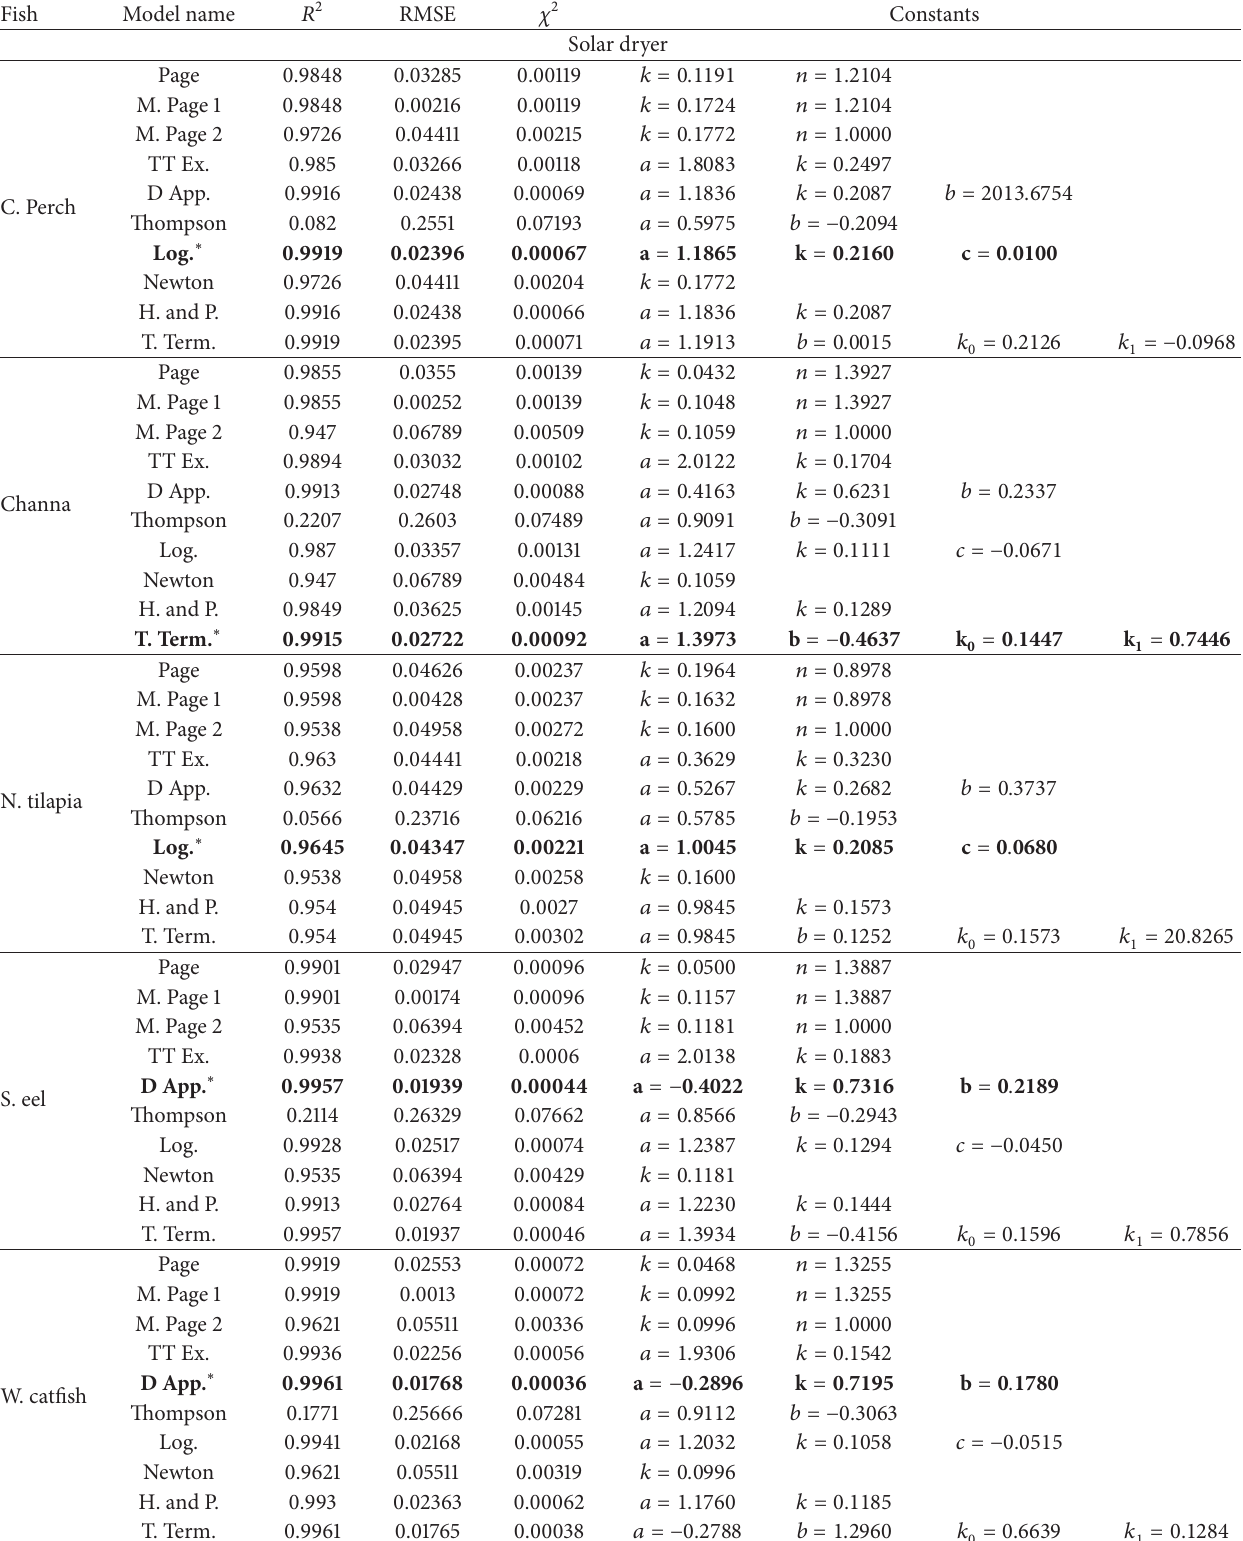
Table 2: Curve fitting criteria for various mathematical models and selected fish species during solar and oven drying.